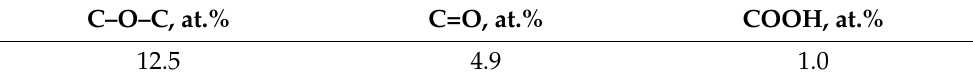
Figure 3. C 1s high-resolution spectrum of the graphene-phosphorene composite. Table 2. Content of the oxygen-containing groups on the GPS surface. Table 2. Content of the oxygen-containing groups on the GPS surface. C–O–C, at.% C=O, at.% C–O–C, at.% C=O, at.%